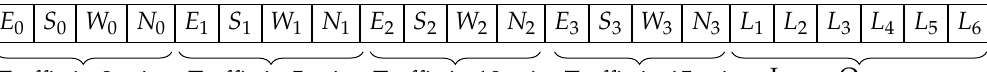
Figure 2. State formulation of the reinforcement learning agent. The first 16 state variables represent the expected traffic intensity per direction (east, south, west, and north) at the expected point in time. The last six positions represent the current number of aircraft in each traffic